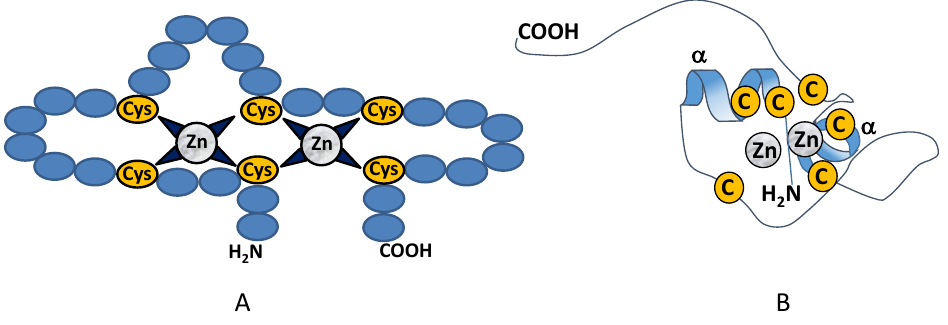
Figure 4. Primary ( A ) and secondary ( B ) structures of the Zn 2 C 6 domain.